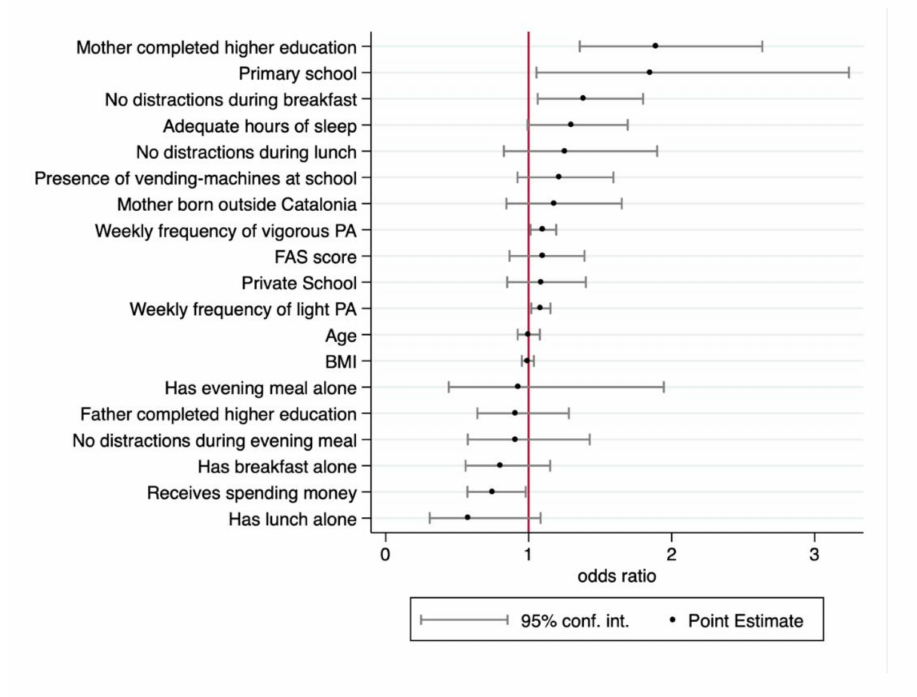
Figure 2. Results of the logistical model for factors associated with optimal adherence to the Mediterranean diet (MD). PA = physical activity; FAS = Family A ffl uence Scale; BMI: body mass index. The model includes Wald χ 2 (17) = 91.91 ( p -value <